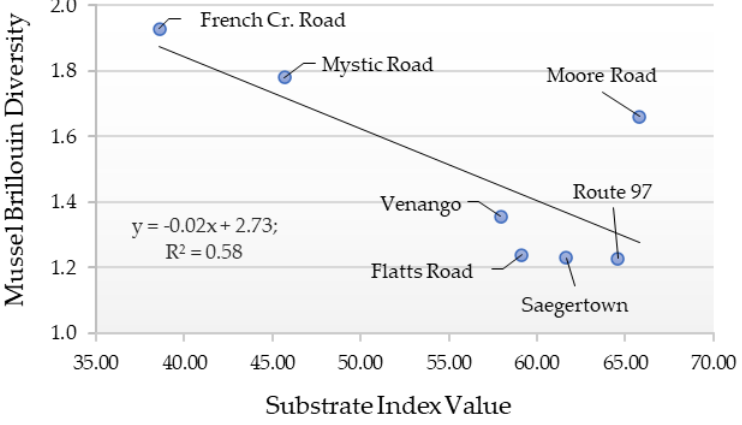
Figure 3. Relationship between Unionidae mussel Brillouin diversity values and substrate index values across the sampling sites in the French Creek watershed.